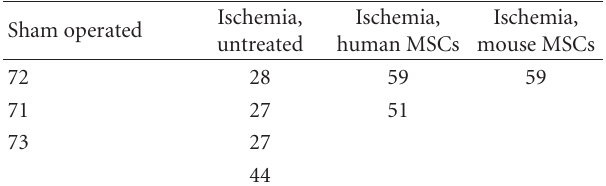
Table 1: Number of cells/field in the various experiments. Same data as Figure 2, however, note that in Figure 2 the 2 MSC groups (human and mouse) were pooled. See text for more